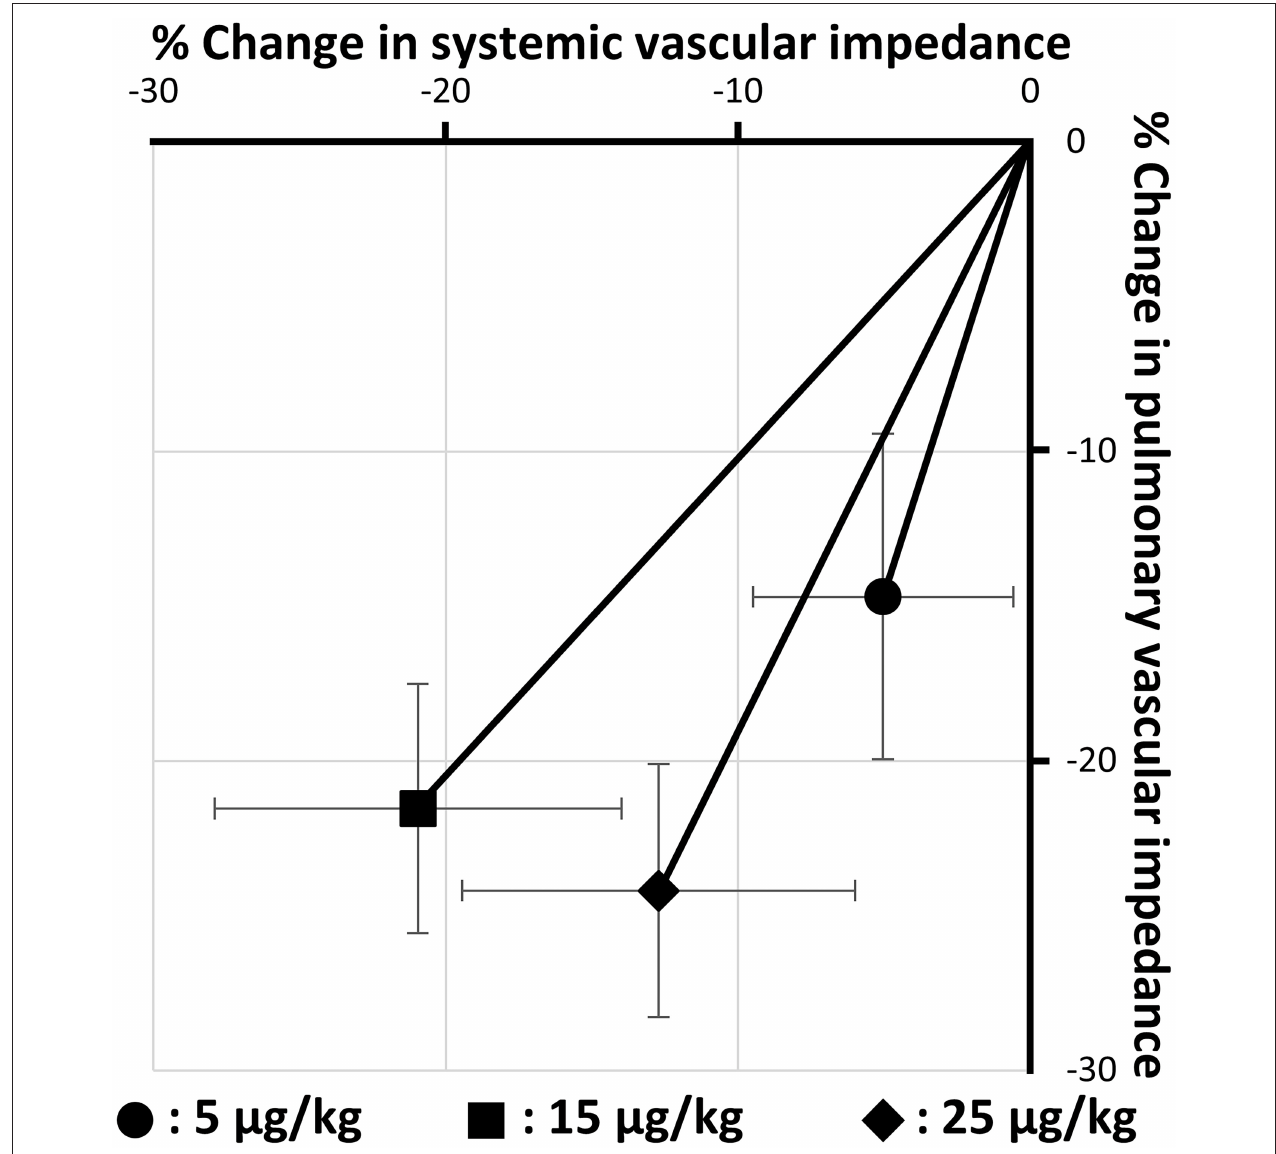
FIGURE 1 | Changes in pulmonary and systemic vascular impedance by three doses of beraprost sodium administration (5, 15, and 25 µ g/kg). Values are the means ± standard deviations.